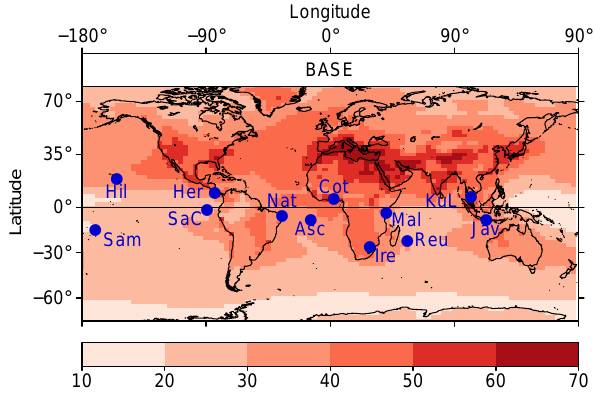
Fig. 4. Modelled five year mean near surface ( < 720m) O 3 (ppb) for the year 2000 (BASE). Locations of measurement sites used in Fig. 3 are shown. Sam = Samoa, Hil = Hilo, SaC = San Christobal, Her = Heredia, Nat = Natal, Asc = Ascension, Cot = Cotonou, Ire = Irene, Mal = Malindi, Reu = Reunion, KuL = Kuala Lumpar, Jav = Java.